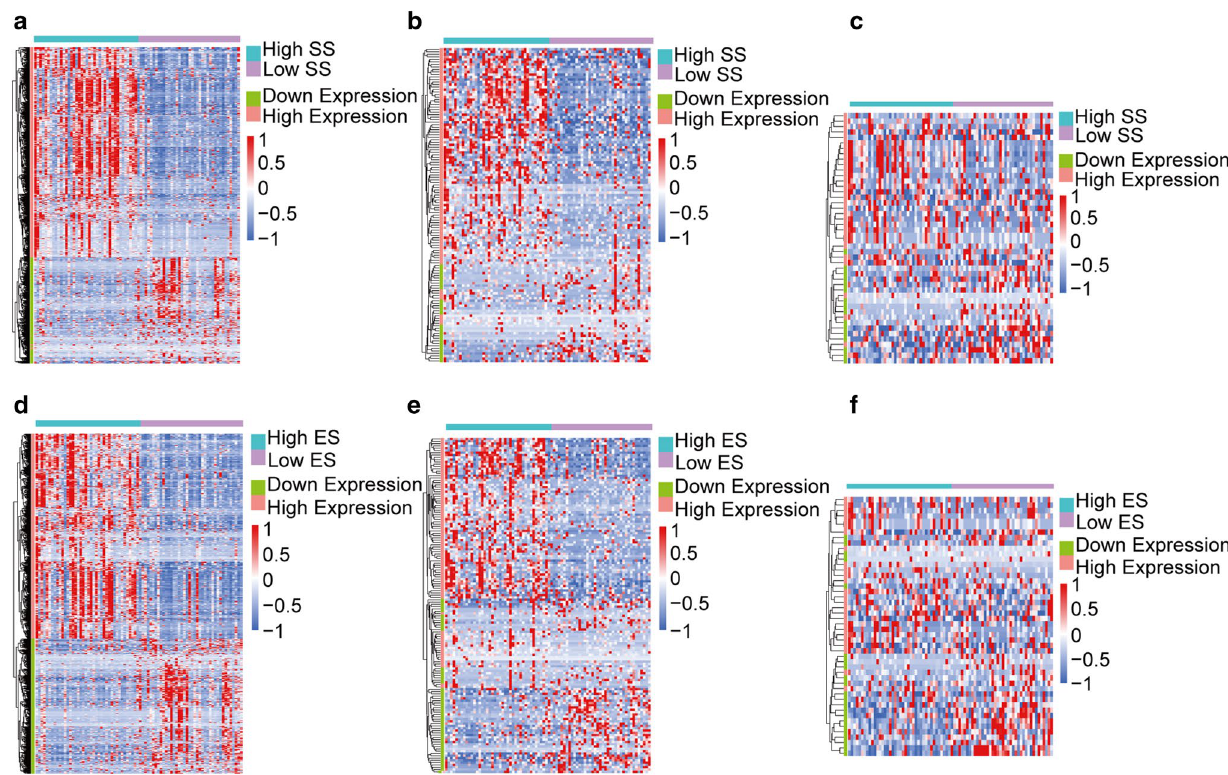
Fig. 2 Heatmap of differentially expressed genes based on Stromal/ESTIMATE Score. a – c Differentially expressed mRNAs, lncRNAs, miRNAs s in the high and low Stromal Score groups. d – f Differentially expressed mRNAs, lncRNAs, miRNAs s in the high and low ESTIMATE Score